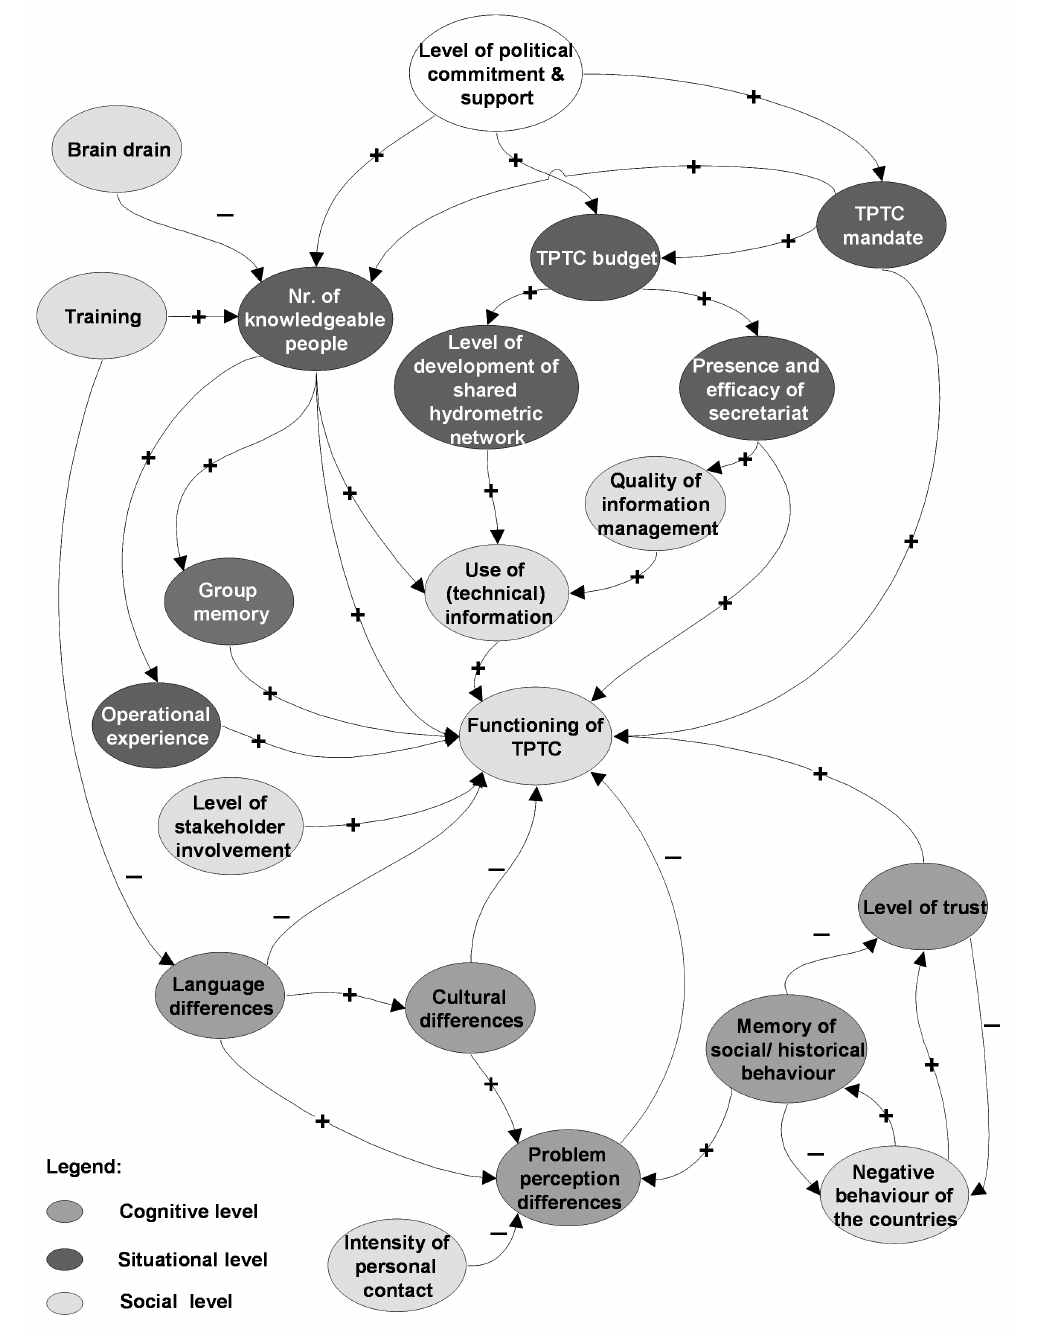
Fig. 2 . Causal diagram of issues in the decision-making process on the Incomati River Basin. Factors of influence are placed in an oval. An arrow means a causal influence. The sign indicates whether a factor increases (+) or decreases (-) as the result of an increase in the source